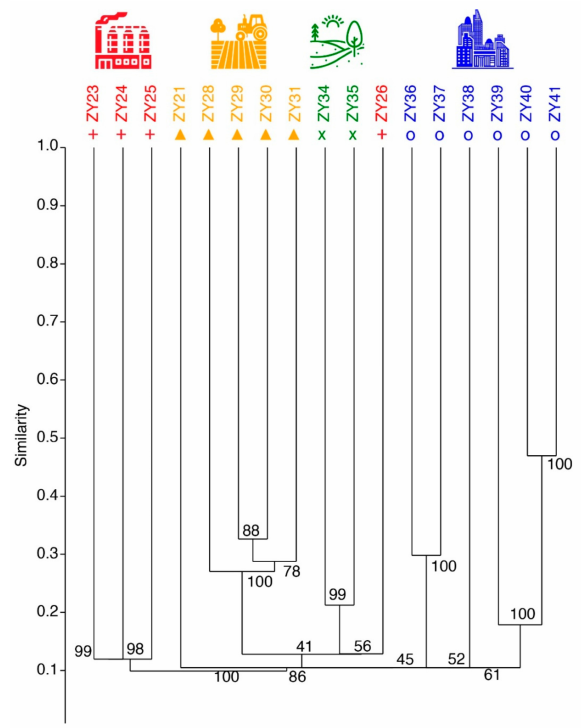
Figure 4. Cluster analysis (UPGMA Bray-Curtis) of the 16S rRNA gene pyrosequencing of bacterial communities. Red crosses indicate samples from the industrial zone, orange triangles those from the agricultural one, green cosses the natural zones, while blue circles the urban